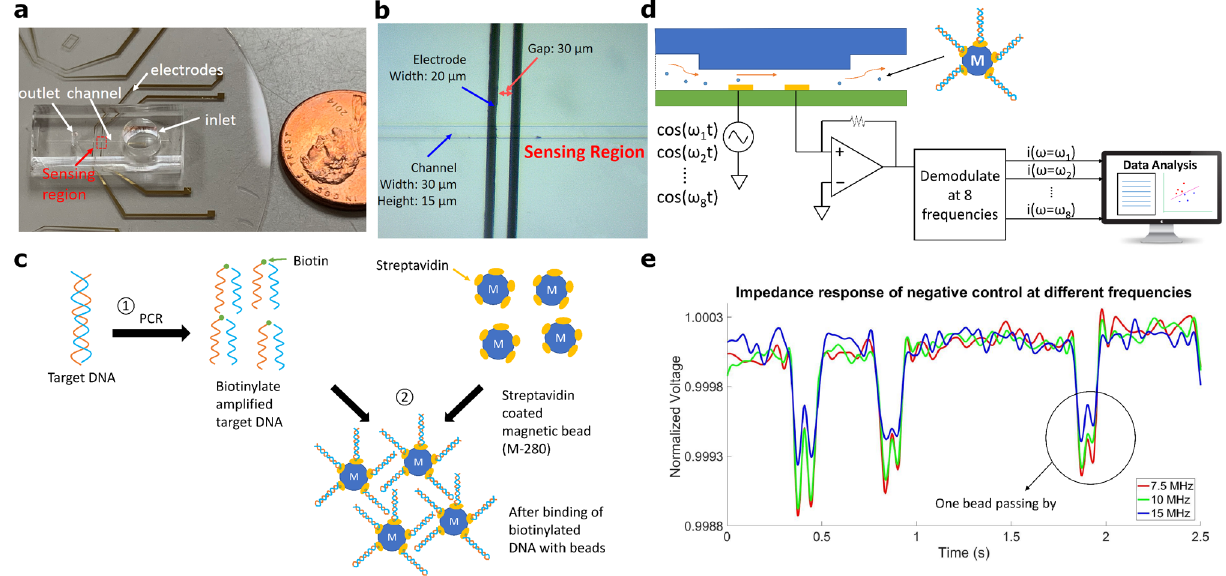
Figure 1. Strategy overview. ( a ) Image of the device in which a soft-lithography made PDMS is integrated with the electrode patterned on the fused silicon wafer. ( b ) The microscope image of channel and electrodes. ( c ) The sample preparation includes ① Amplifying target DNA using polymerase chain reaction (PCR). ② Immobilizing biotinylated target DNA with streptavidin coated paramagnetic beads. ③ Washing and resuspending. ( d ) The schematic diagram of detection. The bead is injected from inlet well using micro pipette. As beads flow through the pore, the impedance change is captured by the lock-in amplifier at multiple frequencies. The data are sent to the PC and analyzed in Matlab. ( e ) Representative data of bare paramagnetic beads passing through the sensing region measured at 7.5 MHz, 10 MHz, and 15 MHz